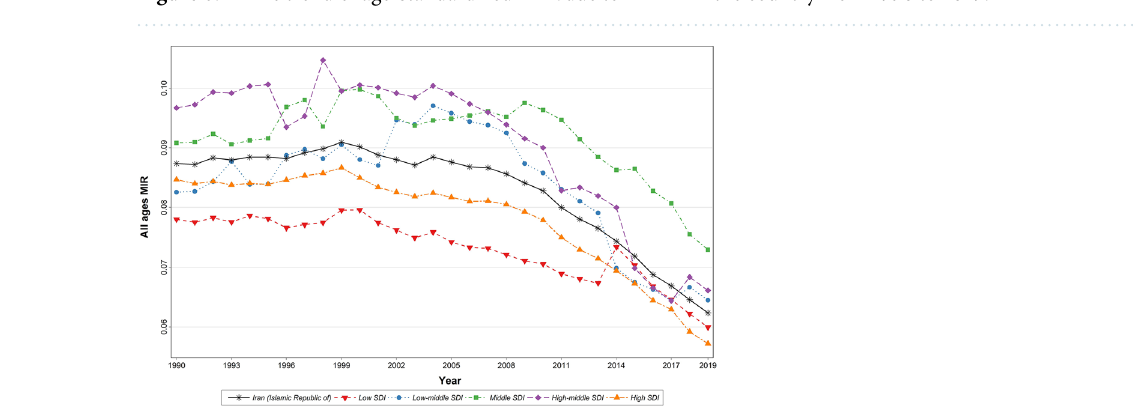
Figure 6. Time trend of age-standardized MIR due to T1DM in the country from 1990 to 2019.